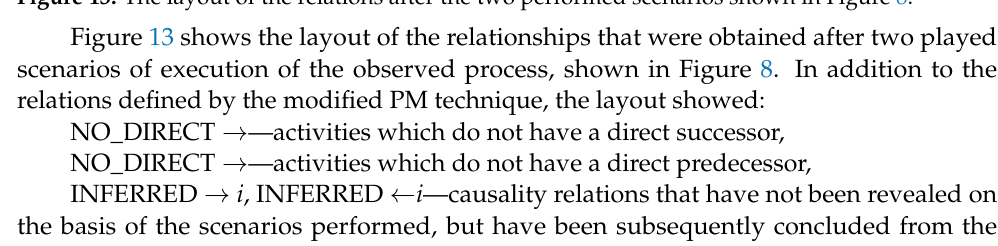
Figure 13. The layout of the relations after the two performed scenarios shown in Figure